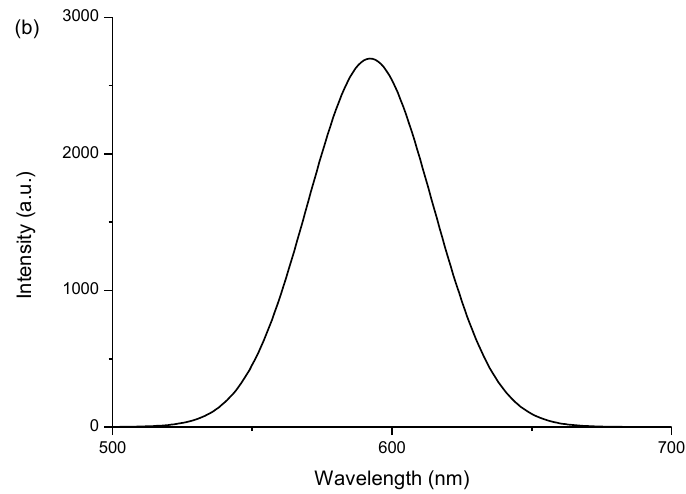
Figure 2. ( a ) Ultraviolet-visible (UV-VIS) absorption spectrum; and ( b ) room temperature solution photoluminescence (PL) emission spectrum of the ZnS:Mn-Asp NCs. (λ max of the fluorescence peak was 590 nm).